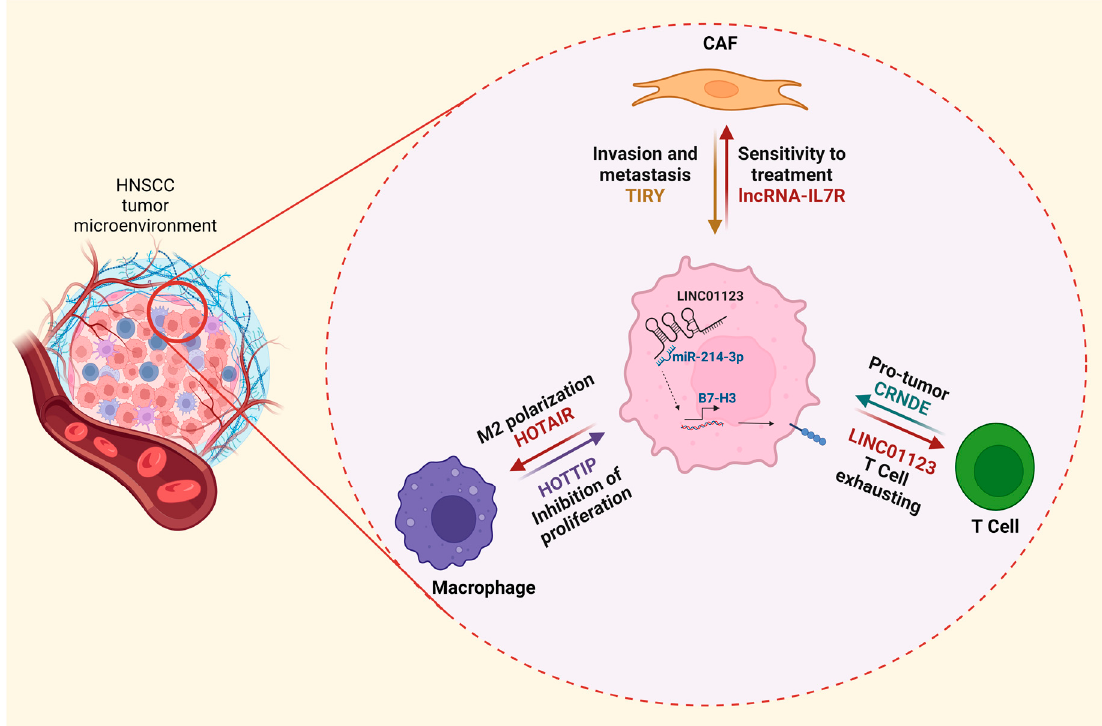
Figure 1. Interactions in the TME are mediated by crosstalk between cells of the immune system, stromal cells, and tumor cells, primarily regulating the behavior of the immune system to induce tumor escape. The image shows examples of crosstalk between some cellular components of the TME through communication with lncRNAs and the effect that is observed.